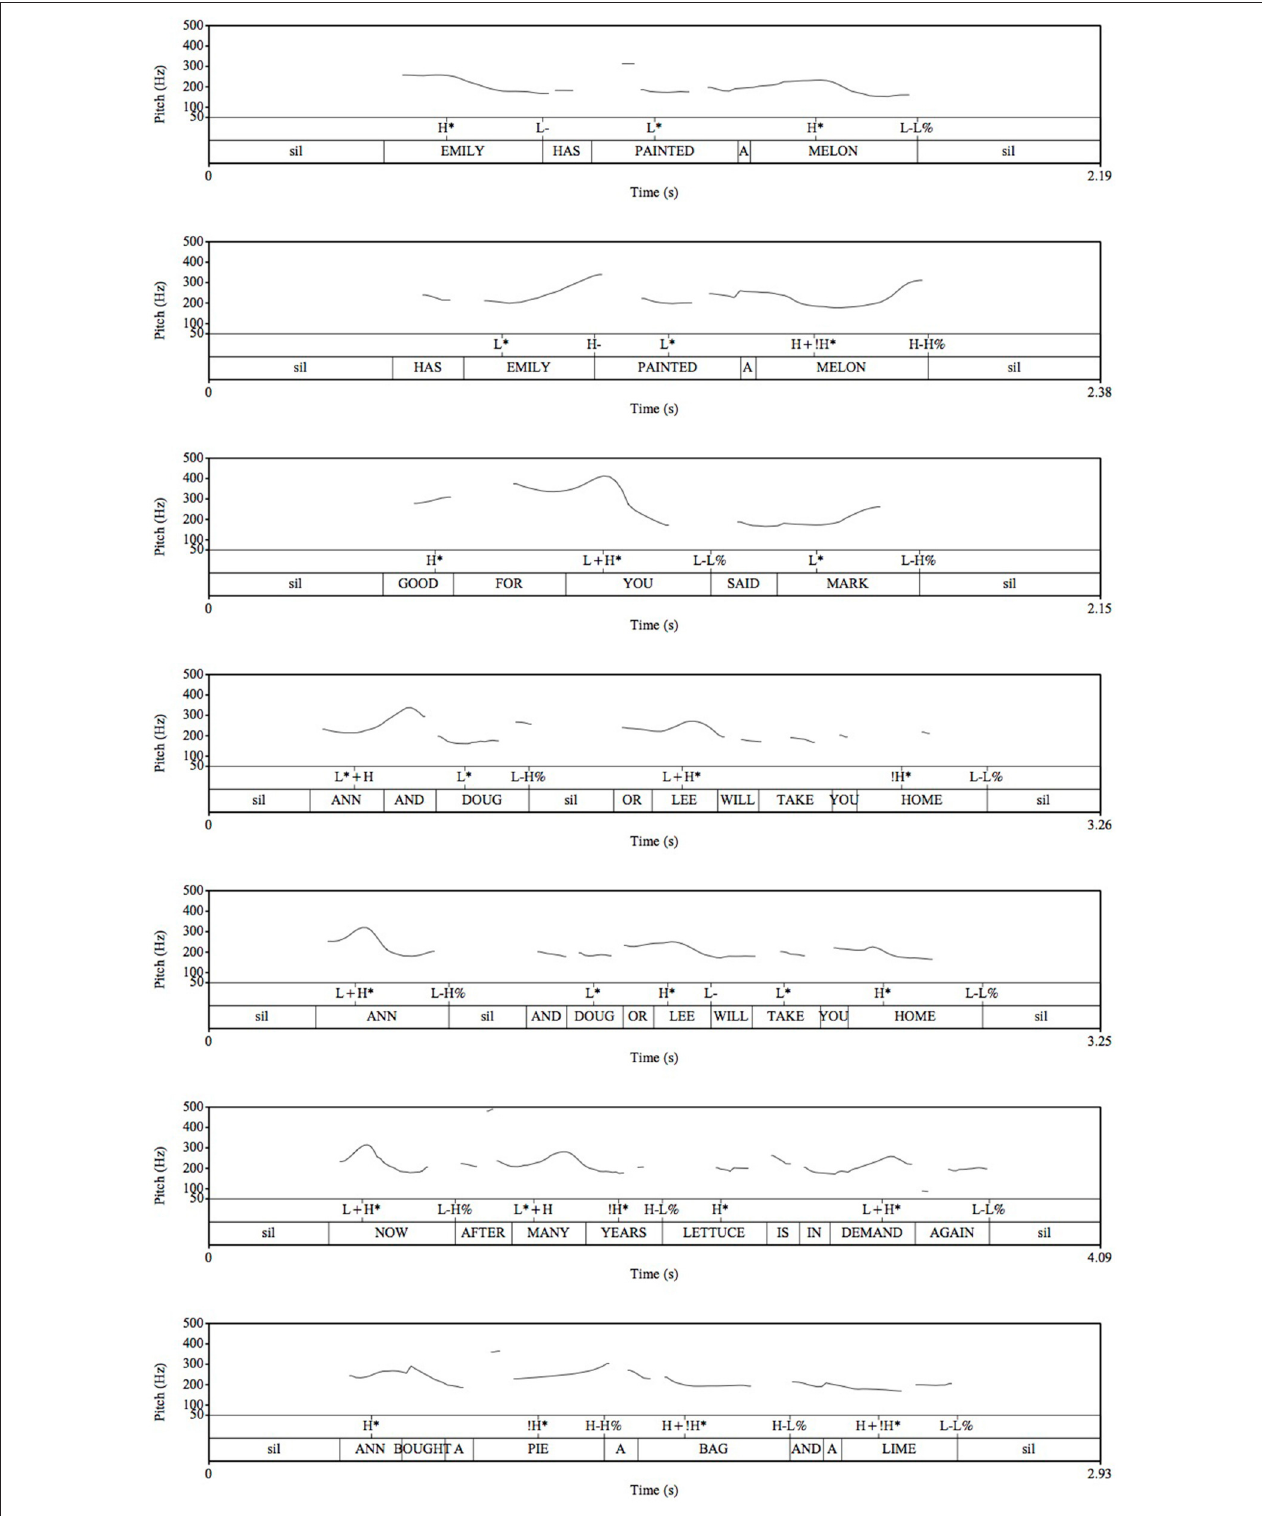
FIGURE 1 | Pitch tracks and Tones and Breaks (ToBI) annotations of one sentence from each stimulus type. See text for description of labels.